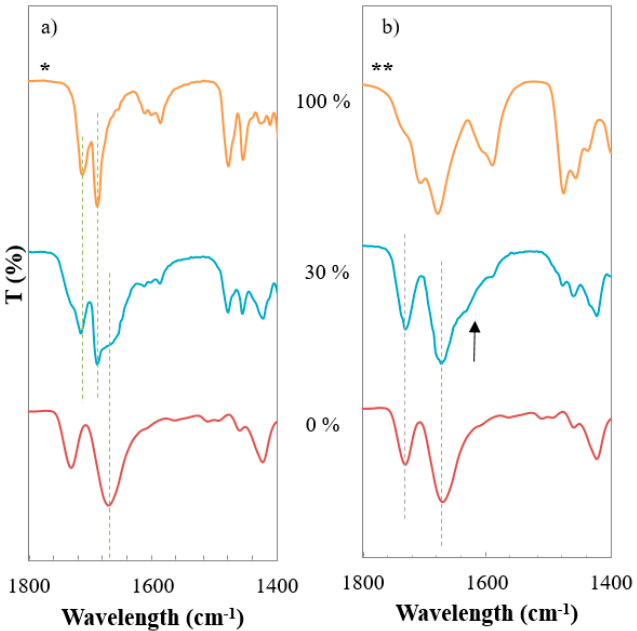
Figure 5. Attenuated total reflectance Fourier transformation infrared spectroscopy (ATR-FTIR) spectra of ( a ) physical mixtures, ( b ) solid dispersions of PVPVA-IND. Numbers indicate the content of IND, * γ -form IND, ** amorphous IND. The lines mark the position of the carbonyl bands and the arrow indicates the appearance of a new band.